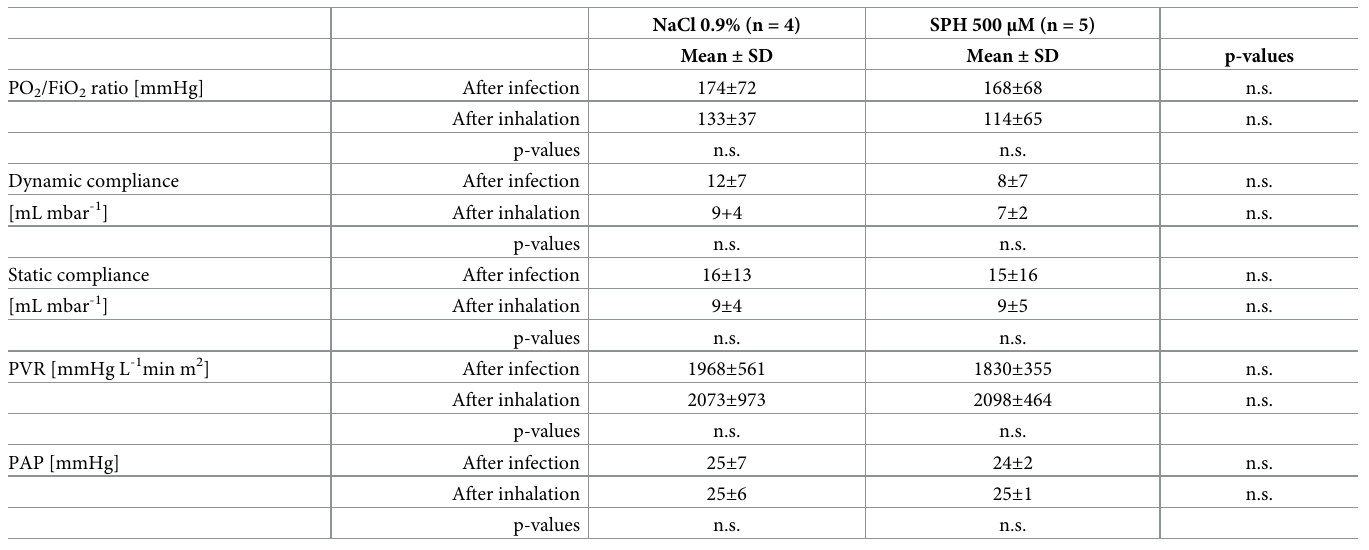
Table 2. Analysis of functional lung parameters during EVLP